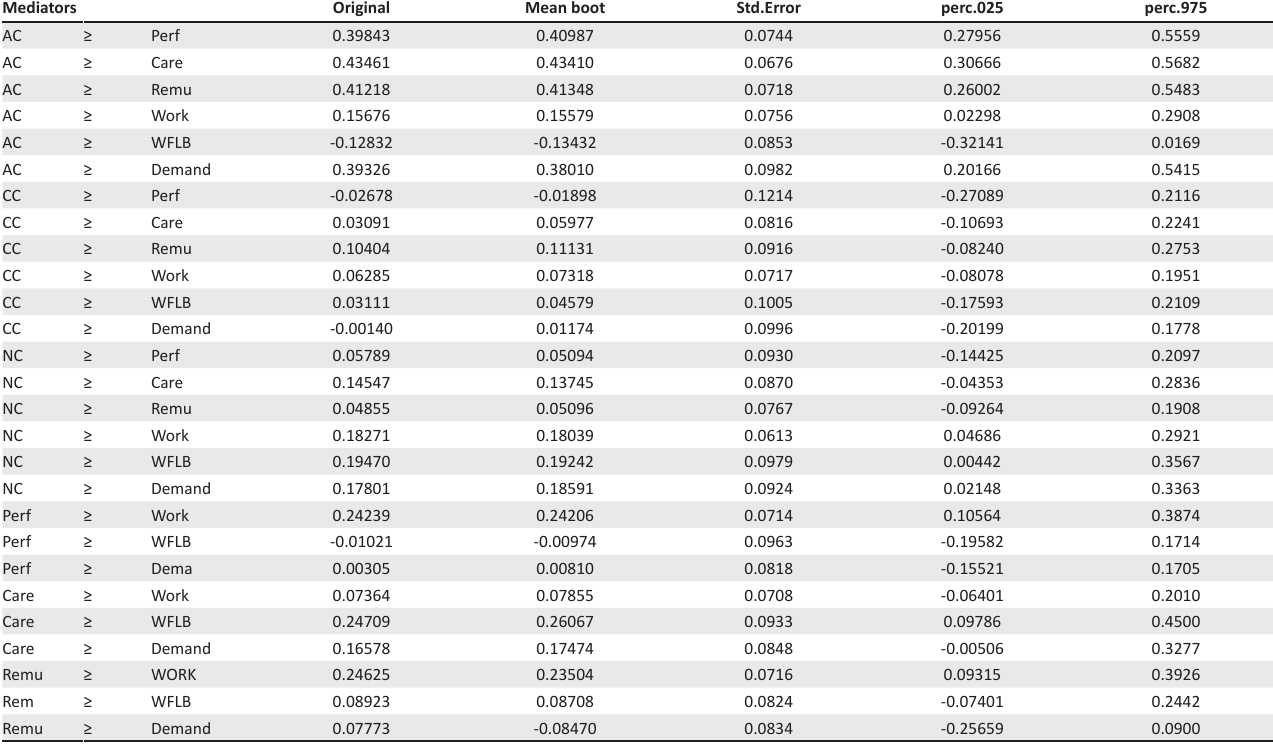
TABLE 2: Direct relationship estimation of parameters and associated standard errors. Mediators